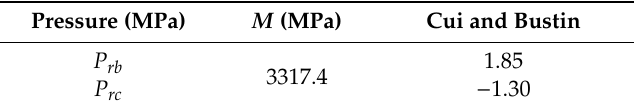
Figure 12. Changes in the coal permeability of two types of coal from the San Juan basin, i.e., Northern and Northeast of Fairway in relation to changes in methane’s pore pressure based on the Cui and Bustin model [3]. Table 9. The rebound pressure P rb and recovery pressure P rc values for the Cui and Bustin model, as obtained for the coal from the San Juan-Northern basin.